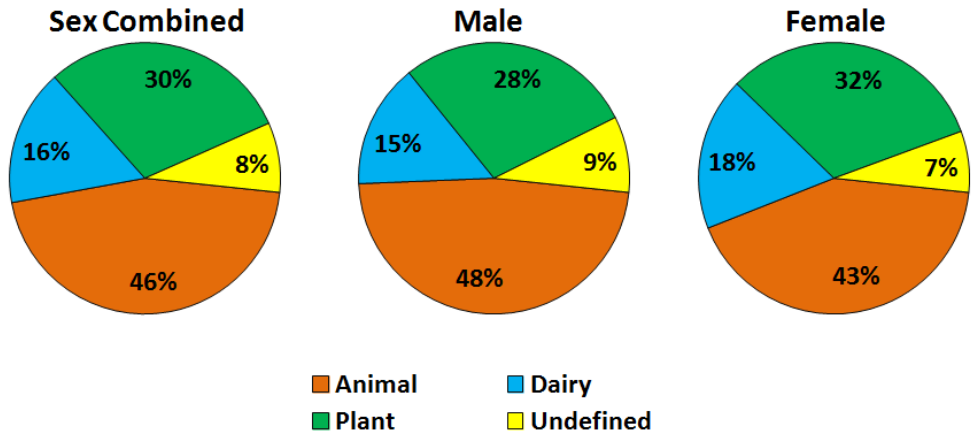
Figure 1. Percentage of animal, dairy, and plant protein intake among US adults combined and separated by sex using data from NHANES 2007–2010 ( n = 10,977, ≥19 years). Total protein intake (mean ± SE) was 82.3 ± 0.8 g/day (98.6 ± 1.1 g/day for men and 67.0 ± 0.7 g/day for women).